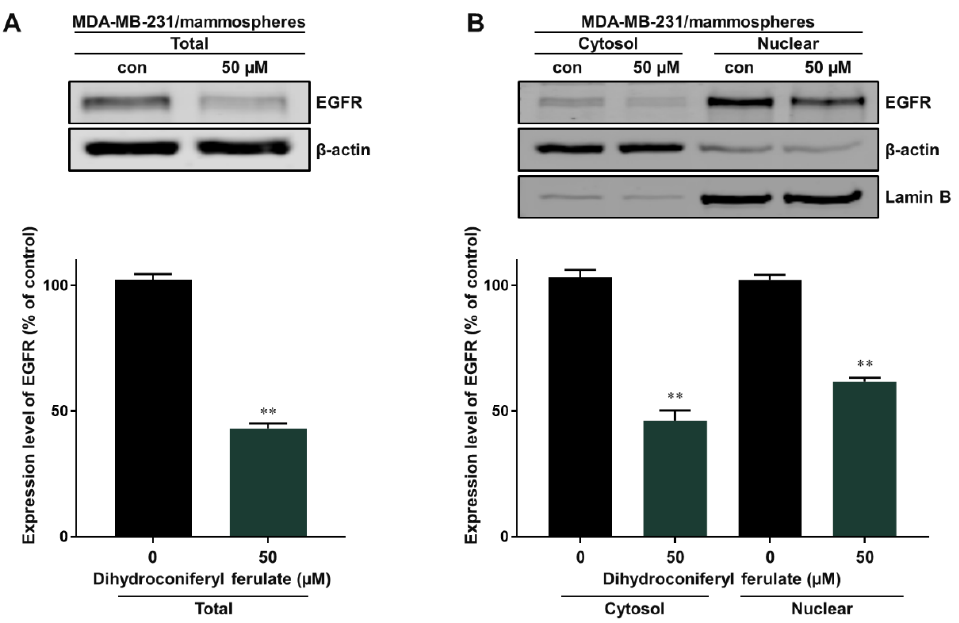
Figure 5. Inhibitory effect of dihydroconiferyl ferulate on EGFR signaling. ( A ) Western blot analysis showing the level of total EGFR measured in tumorspheres derived from MDA-MB-231 cells after treatment with dihydroconiferyl ferulate (50 µM) or DMSO for 48 h. ( B ) The nuclear protein levels of EGFR were examined in MDA-MB-231-derived mammospheres treated with dihydroconiferyl ferulate (50 µM). Dihydroconiferyl ferulate decreases the total and nuclear protein levels of EGFR. Data from the experiments represent the mean ± standard deviation; ** p < 0.01 vs. control.